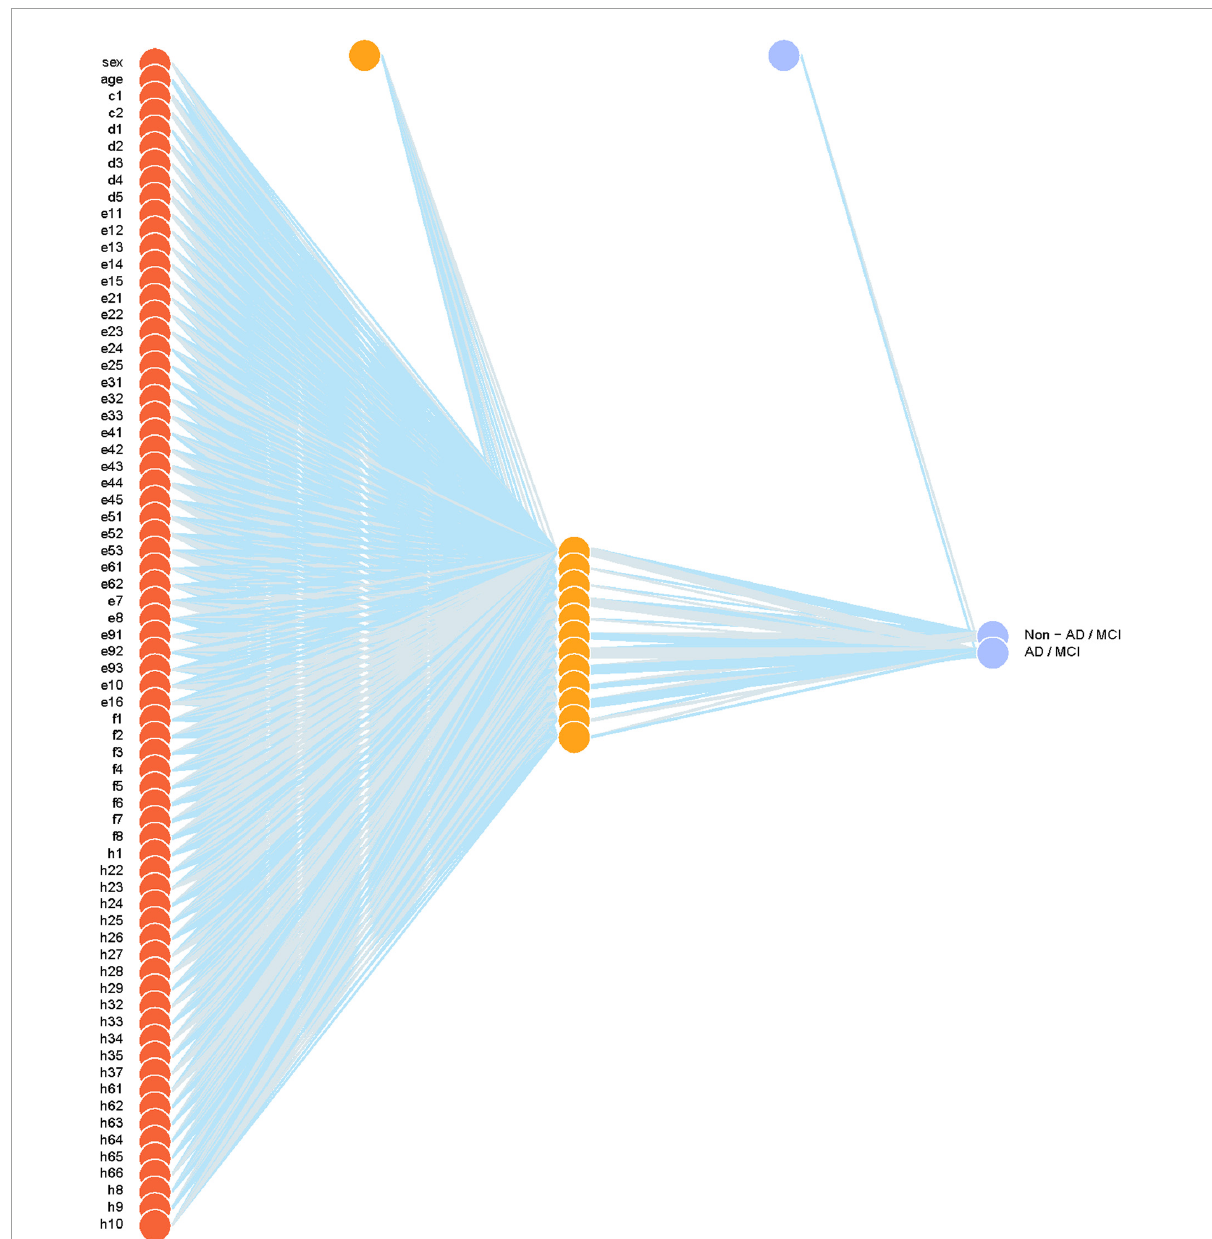
FIGURE4 The final neural network model. Weights are color-coded by sign (blue+, gray − ) and thickness is in proportion to magnitude. Input features include sex, age, Mini-Cog test (c1–c2), Clock Drawing test (d1–d5), Mini-Mental State exam (e11–e15, e21–e25, e31–e33, e41–e45, e51–e53, e61–e62, e7, e8, e91–e93, e10, e16), AD8 screening (f1–f8), education (h1), occupation (h22–h29), marital status (h32–h35, h37), past medical history (h61–66), number of medications (h8), smoking (h9), and drinking